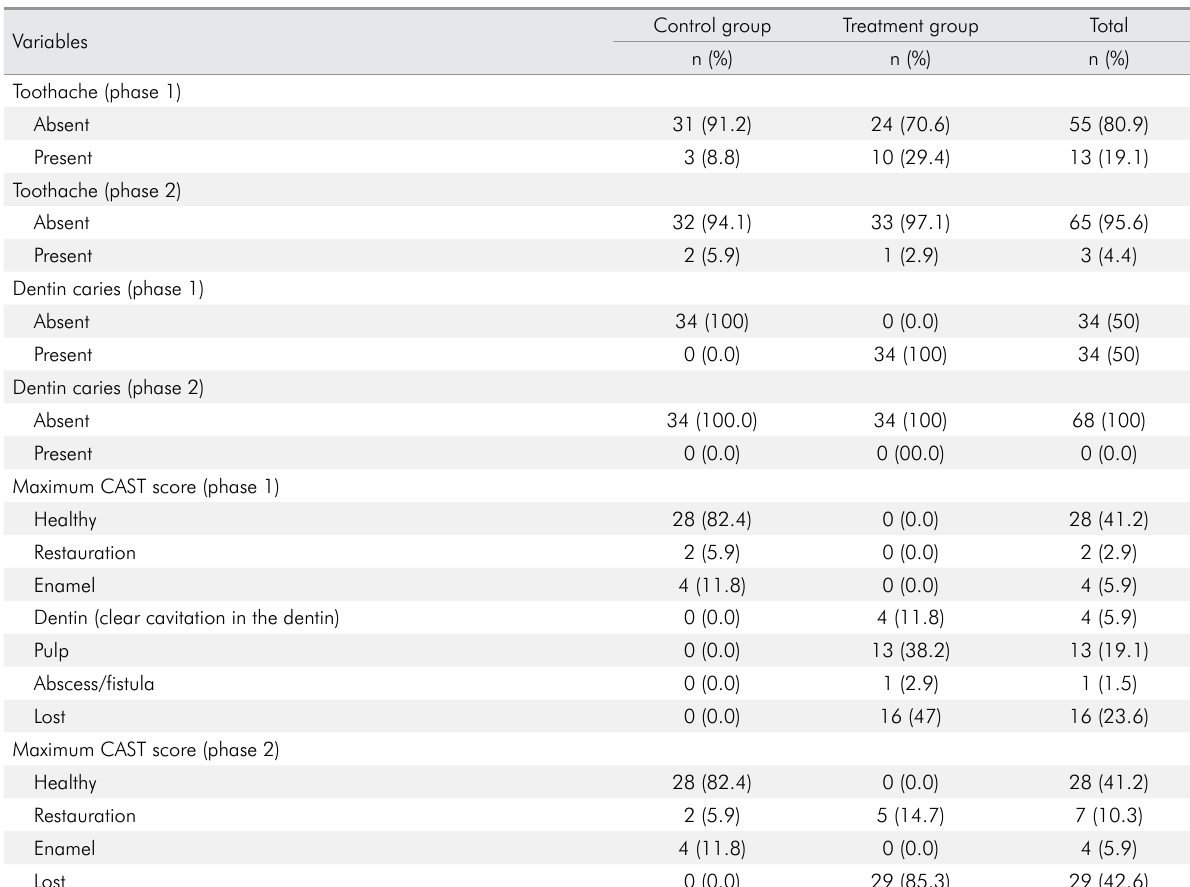
Table 2. Distribution of children according to the occurrence of toothache, dentin caries and maximum CAST score at Phase 1 and Phase